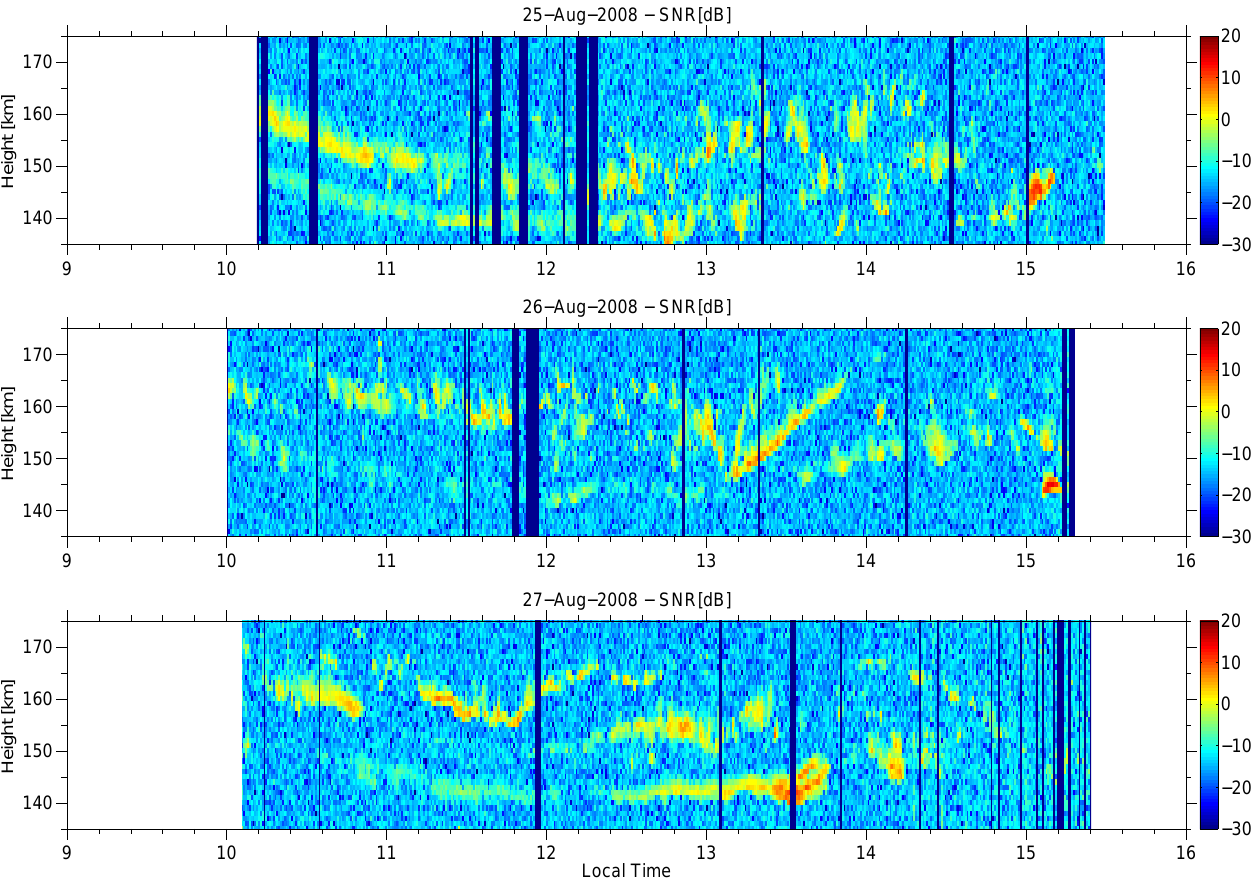
Fig. 3. Range-Time-Intensity (RTI) maps of upper E-region observations made by the S˜ao Lu´ıs radar in Brazil on three consecutive days during 25–27 August